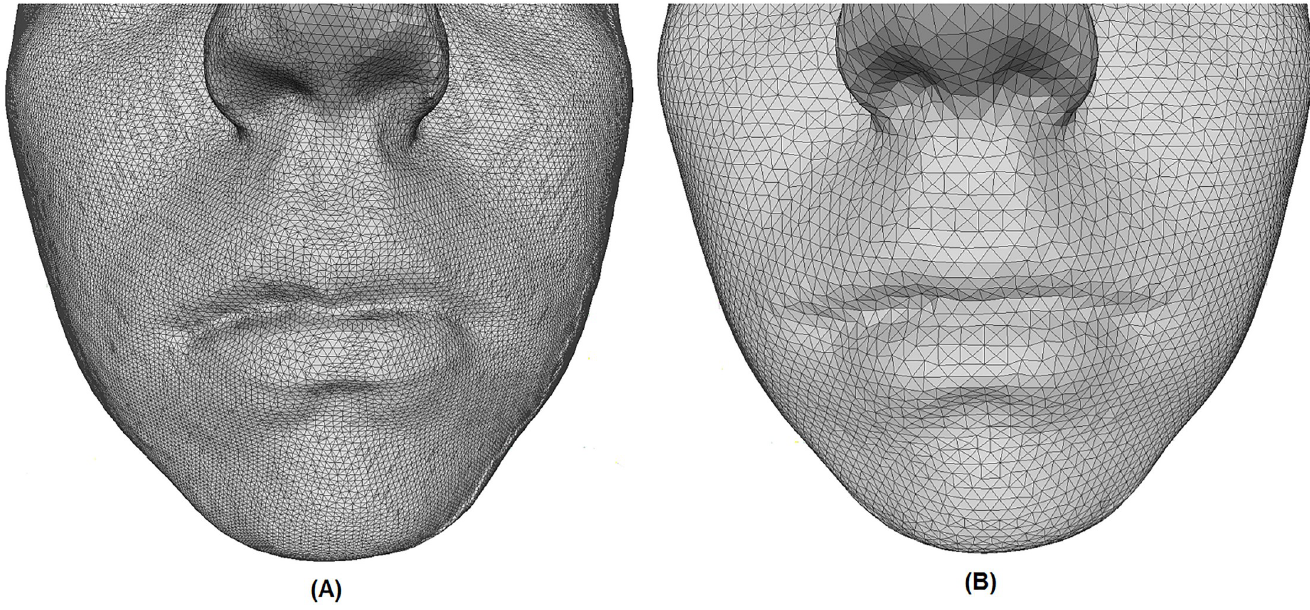
Fig 6. Difference between preprocessed images. (A) Non-regularised face. (B) Regularised face.